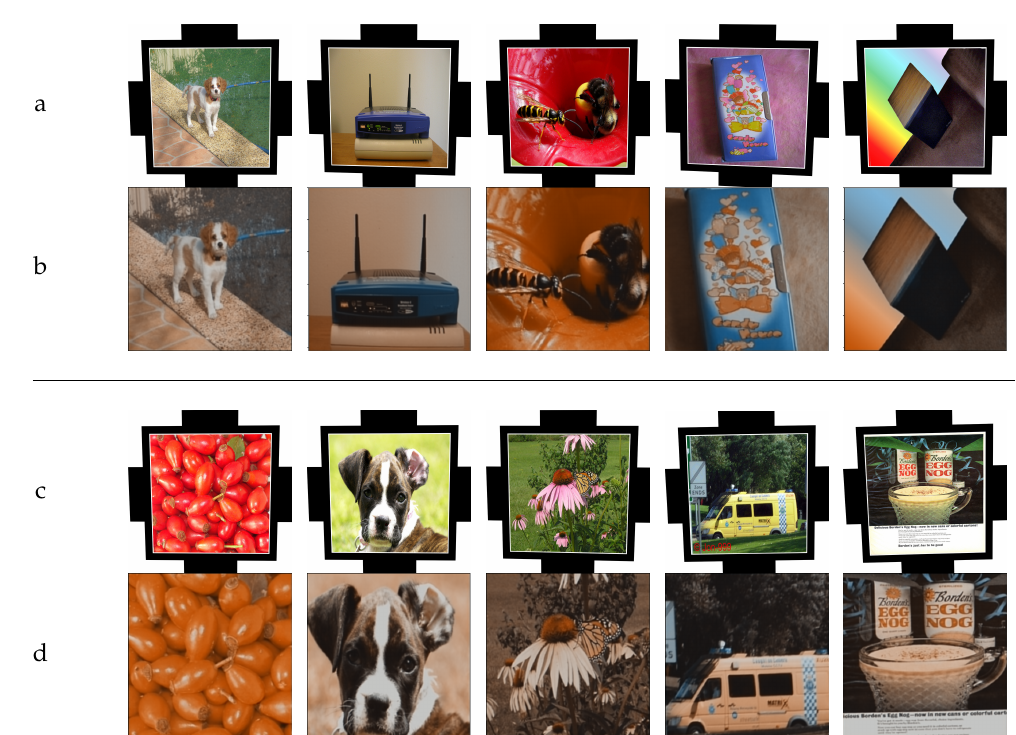
Figure 5. Moiré experimental 2. Examples of image pairs from our test experiment: ( a , c ) pure images; ( b , d ) images (512 × 512) with moiré